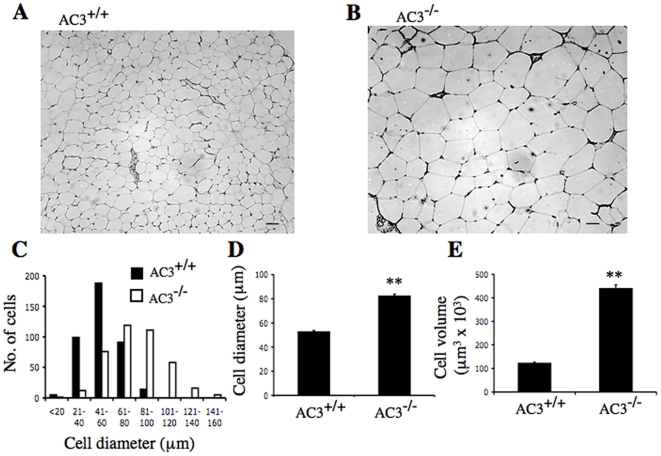
AC3−/− mice have larger adipocytes.Representative hematoxylin sections of epididymal adipose tissue from (A) AC3+/+ and (B) AC3−/− mice. Scale bar, 50 µm. (C) The distribution of adipocyte cell diameter of AC3+/+ and AC3−/− mice. (D) The average adipocyte cell diameter of AC3+/+ and AC3−/− mice. (E) The adipocyte cell volume of AC3+/+ and AC3−/− mice. Data is the average from four AC3−/− and four AC3+/+ mice at 8 months. A total of 400 cells from each genotype were counted. Data are represented as means±SEM. **, p<0.01.